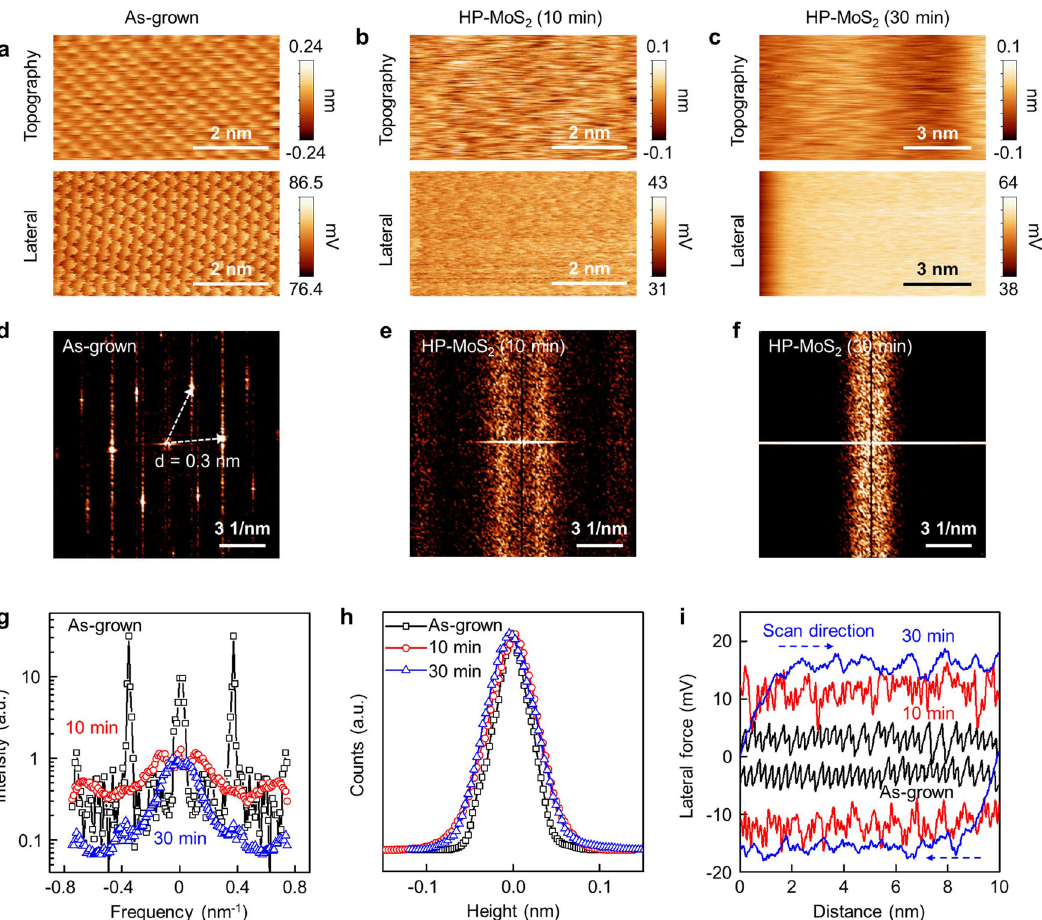
Fig. 7 Atomic scale local frictional properties of HP-MoS 2 . a – c Topography and lateral force images of as-grown MoS 2 , HP-MoS 2 (10 min), and HP-MoS 2 (30 min), respectively. d – f Diffraction patterns obtained from lateral force image of MoS 2 , HP-MoS 2 (10 min), and HP-MoS 2 (30 min), respectively. g The line pro fi le of frequencies extracted from d to f . h The height distributions of MoS 2 samples. The similar shape of three curves indicates the uniform surface despite the defective structure of HP-MoS 2 . i Representative friction loop obtained during a single